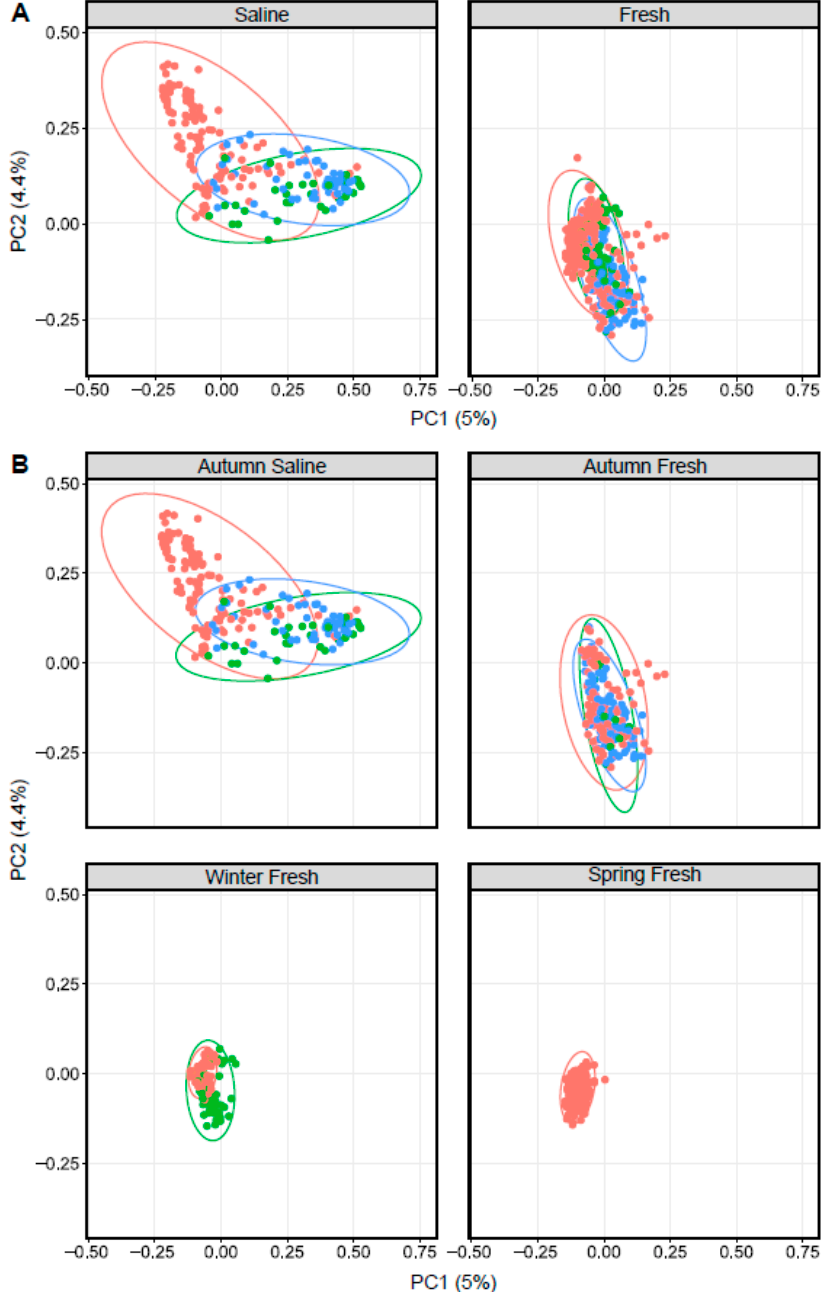
Figure 4. Principal coordinate analysis plots displaying dissimilarity using Bray–Curtis distances between Arctic char (red dots), cisco (bright green) and lake whitefish (blue) in ( A ) saline and freshwater, as well as ( B ) different seasonal habitats as indicated above each graph.